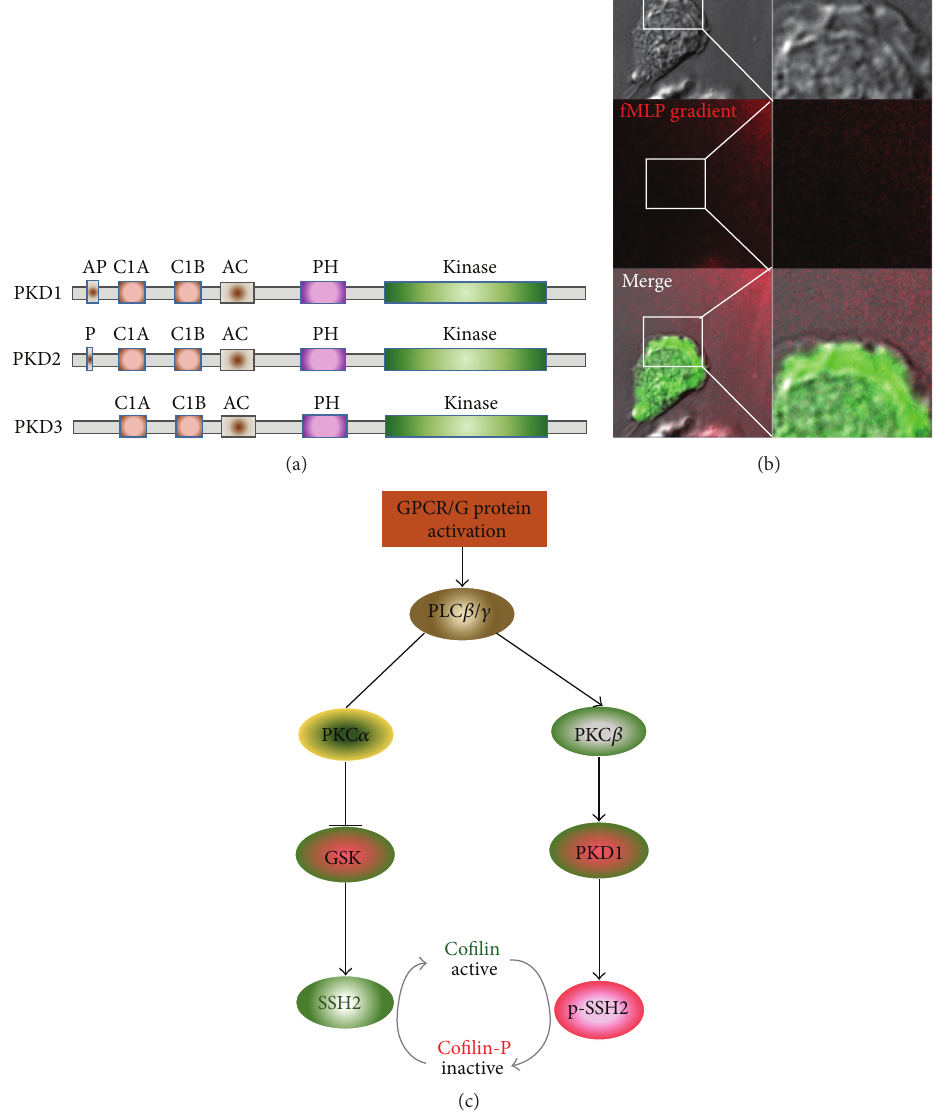
Figure 3: PKD, a direct effector of the PLC/PKC axis, is required for neutrophil chemotaxis. (a) Scheme shows the domain compositions of the three isoforms of the PKD family, PKD1–3. All three PKD isoforms have a conserved N-terminal C1A-C1B-AC-PH domain connected to a serine/threonine kinase domain at the C-terminal. The C1A domain binds to DAG for membrane targeting, while the C1B domain has a higher affinity for phorbol ester. C1A and C1B domains are separated by a long spacer, an acidic amino-acid-rich region (AC domain). The PH domain seals the kinase domain of PKD1 and inhibits its kinase activity. PKD1 also contains an alanine- and proline-rich region (AP domain) in its N-terminus while PKD2 has a proline-rich region (P domain) in its N-terminus. (b) PKD localizes at the backside leading edge of chemotaxis cells. HL60 cells expressing PKD1-GFP (Green) chemotax in 100nM fMLP gradient (Red). In order to visualize the gradient, 100nM fMLP was mixed with fluorescent dye Alexa 594. A differential interference contrast (DIC) image is also shown in order to portray the protrusion area of the leading edge. (c) Scheme shows the signaling pathways in which PKD1 phosphorylates cofilin phosphatase SSH2, ultimately regulating cofilin activity in GPCR-mediated neutrophil